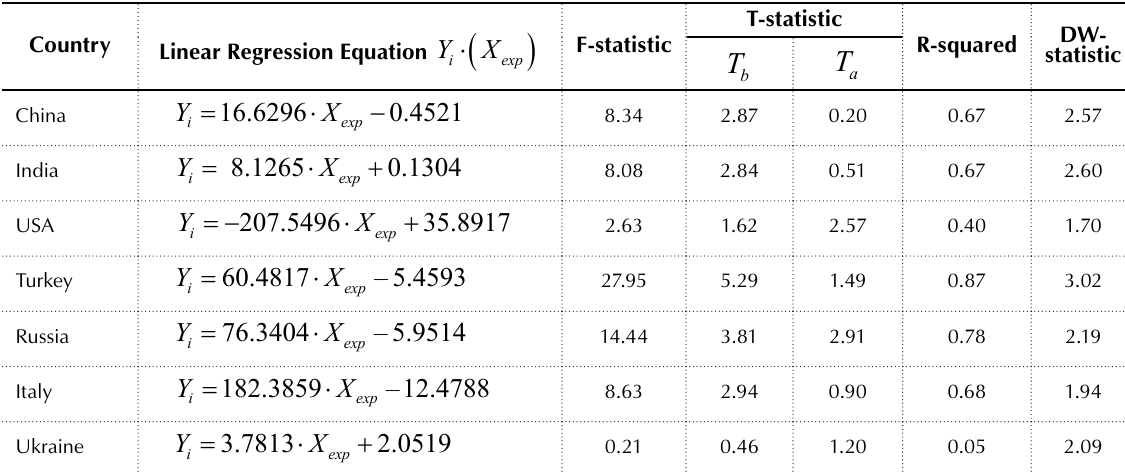
Table 2. Communications export and gross vegetable production for the years 2010–2016 *